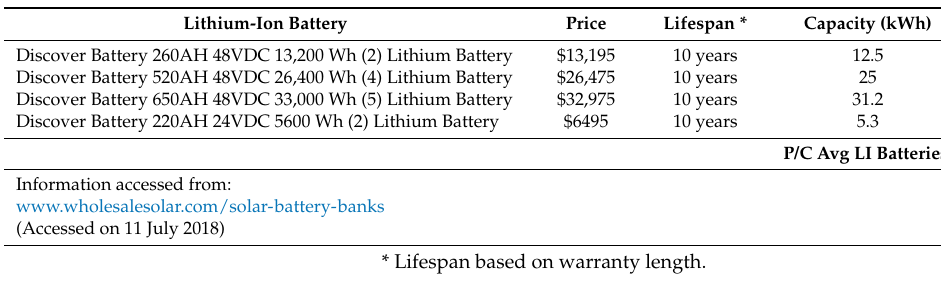
Table A7. Price per capacity scaling factor calculations for PV arrays.